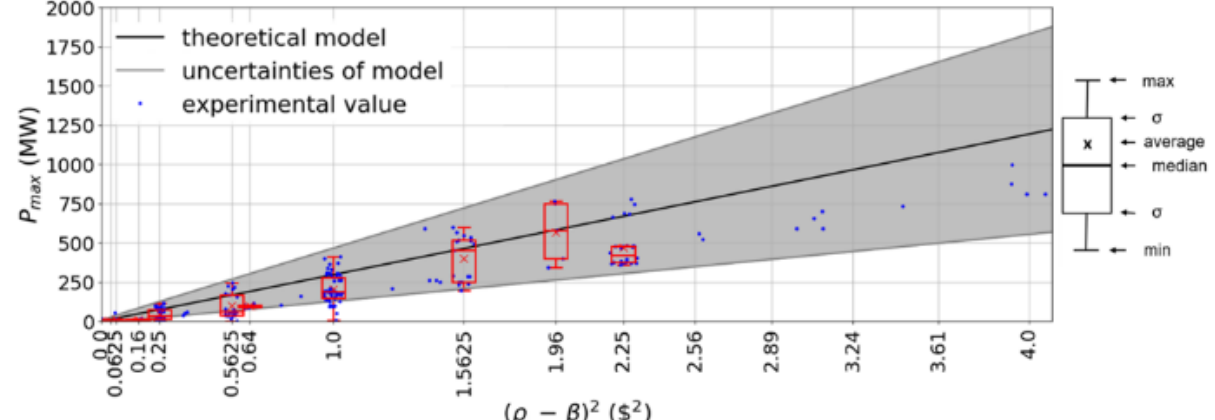
Figure 5: Comparison of the theoretical models with experimental data for maximum power.